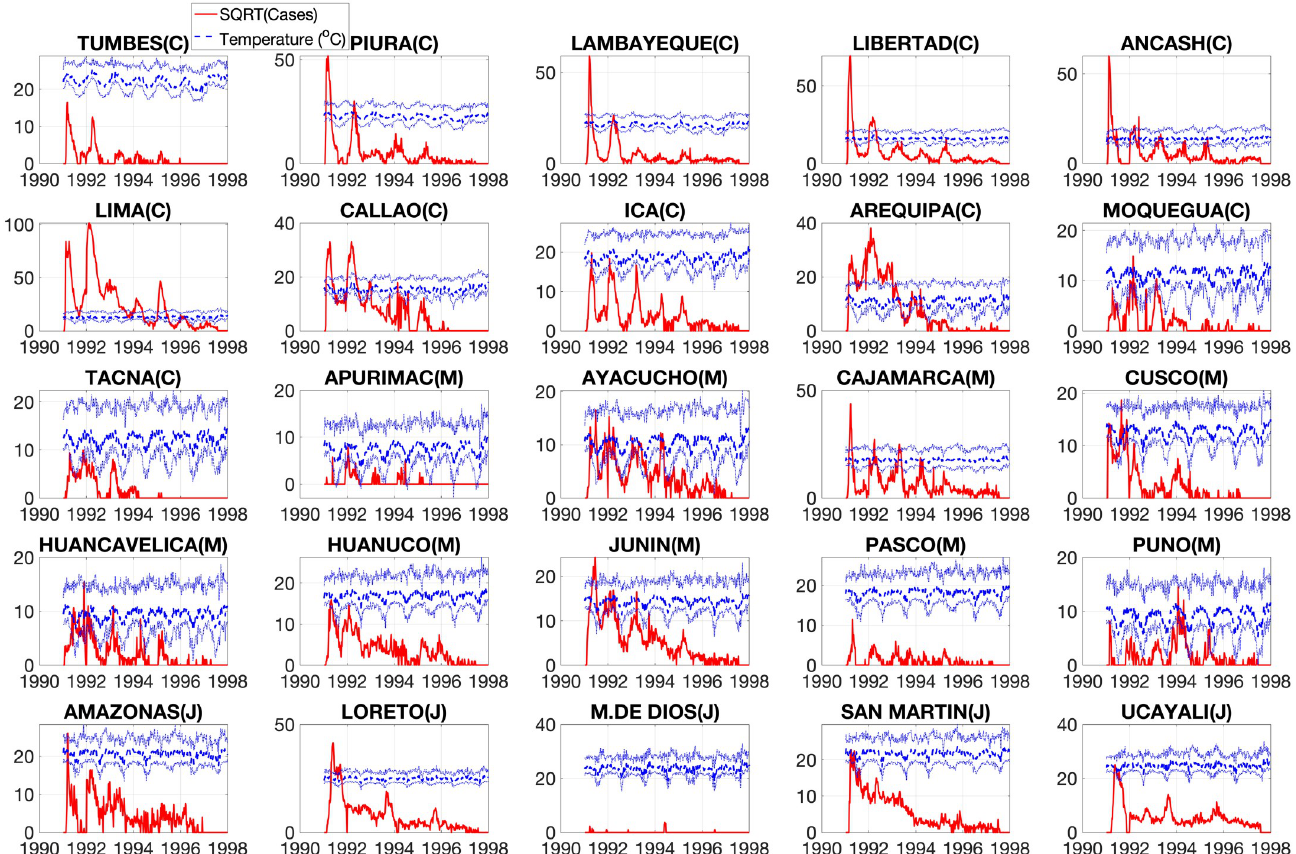
Fig 3. Time series of weekly cholera cases (red solid line) and temperature (blue curves; minimum, mean, and maximum temperature) across 25 departments during the 1991-1997 cholera epidemic in Peru.